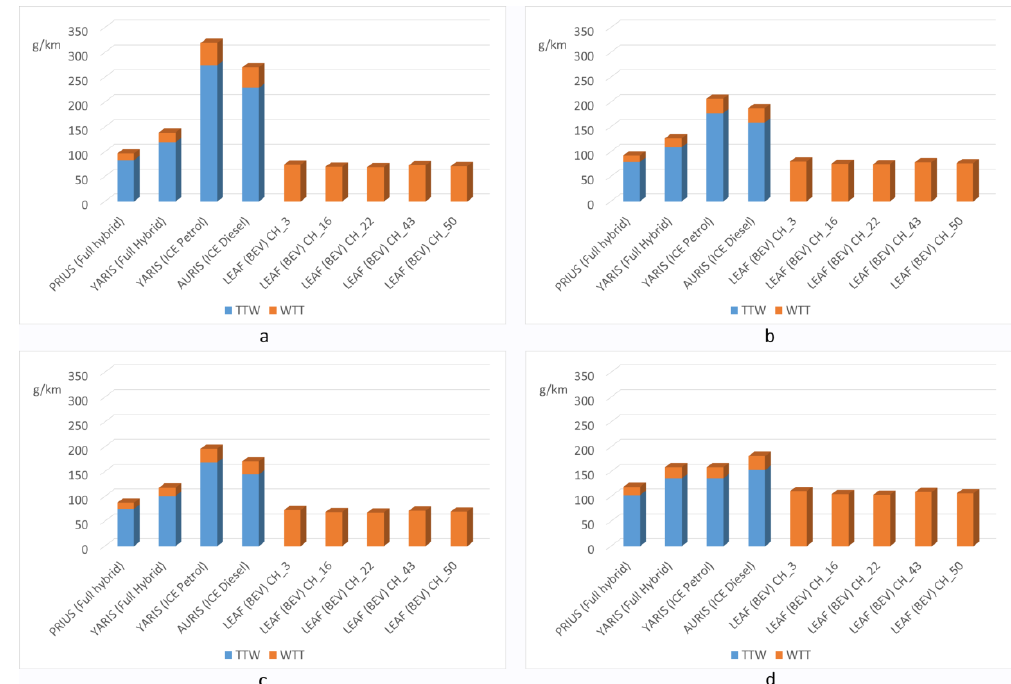
Figure 11. GHG emission of the vehicle analyzed in urban roads with high traffic density ( a ), urban low traffic intensity ( b ), extra-urban ( c ), and motorway ( d ).